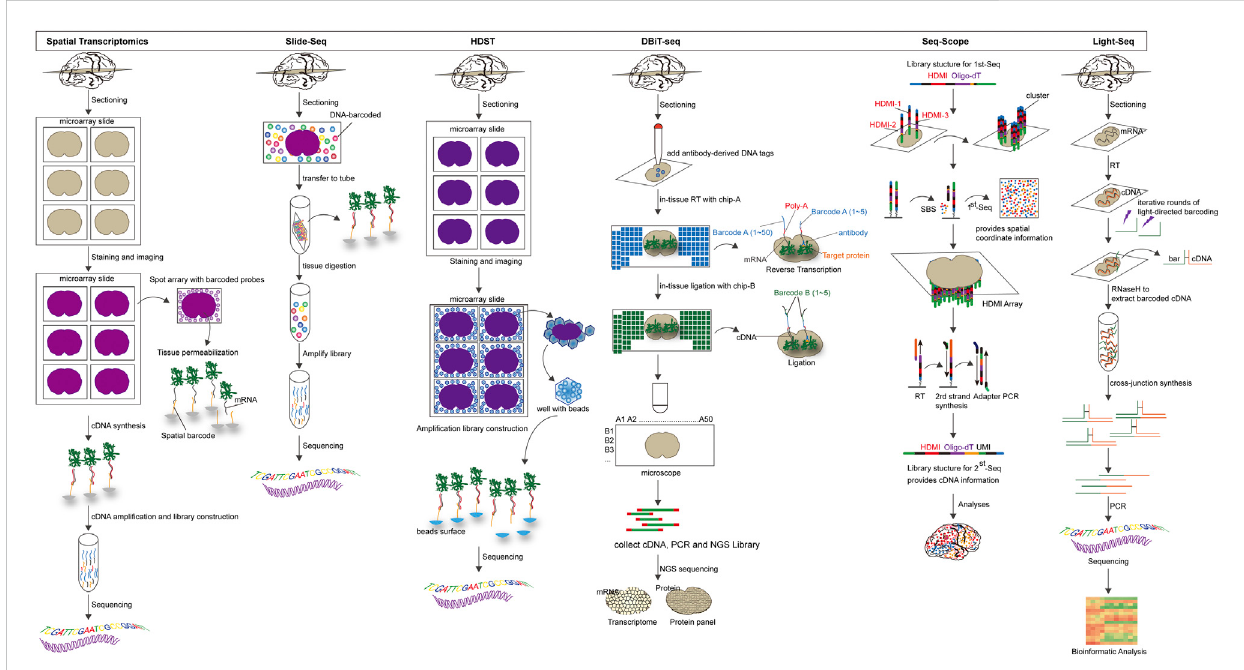
FIGURE 4 The overview and principle of in situ capture-based spatial transcriptome